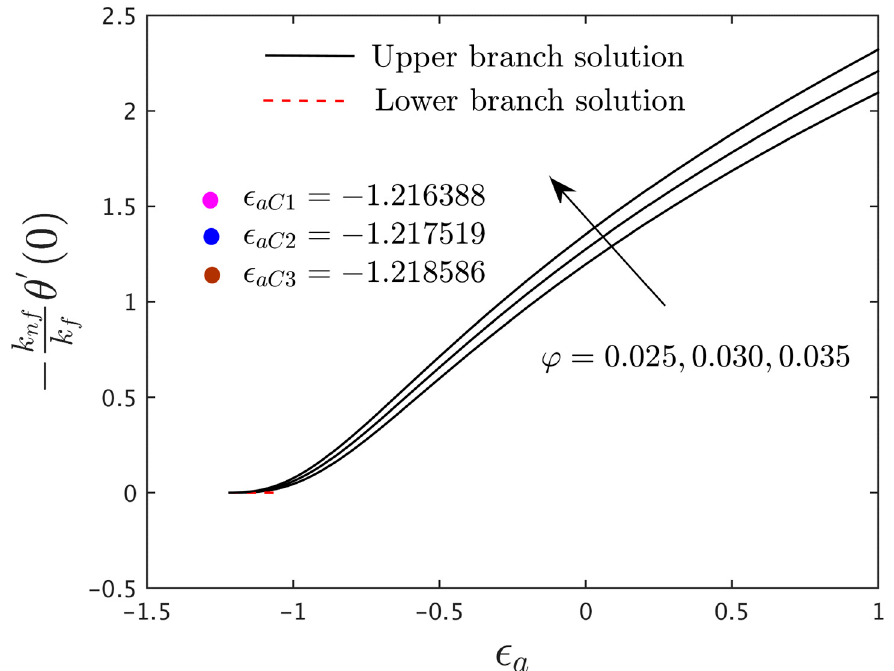
ε for the numerous values of ϕ when Pr Figure 3. The rate of heat transfer versus ε a for the numerous values of ϕ when Pr a